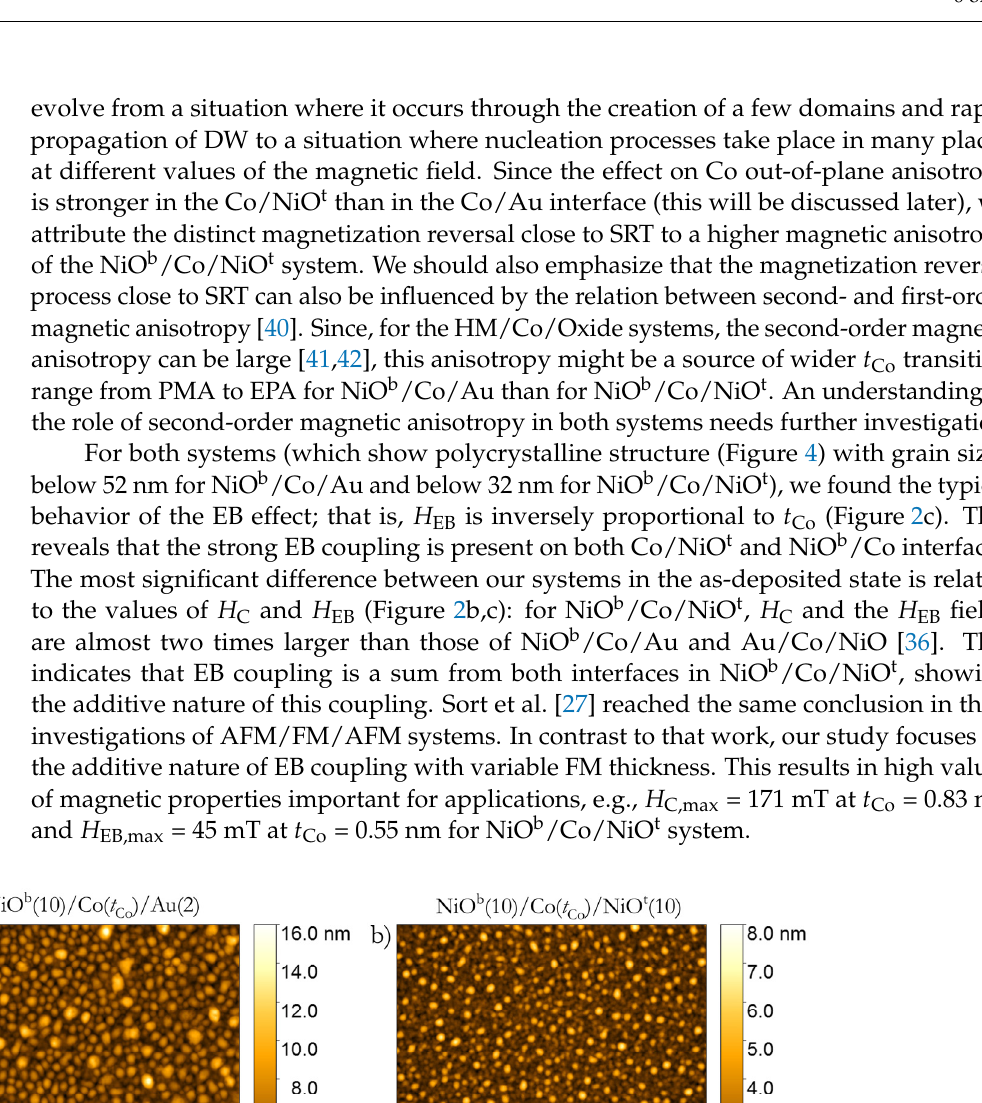
Figure 4. Surface topography measured by atomic force microscope of the as-deposited ( a ) NiO b /Co-wedge/Au system at t Co = 1 nm and ( b ) the NiO b /Co-wedge/NiO t system at t Co = 1 nm.